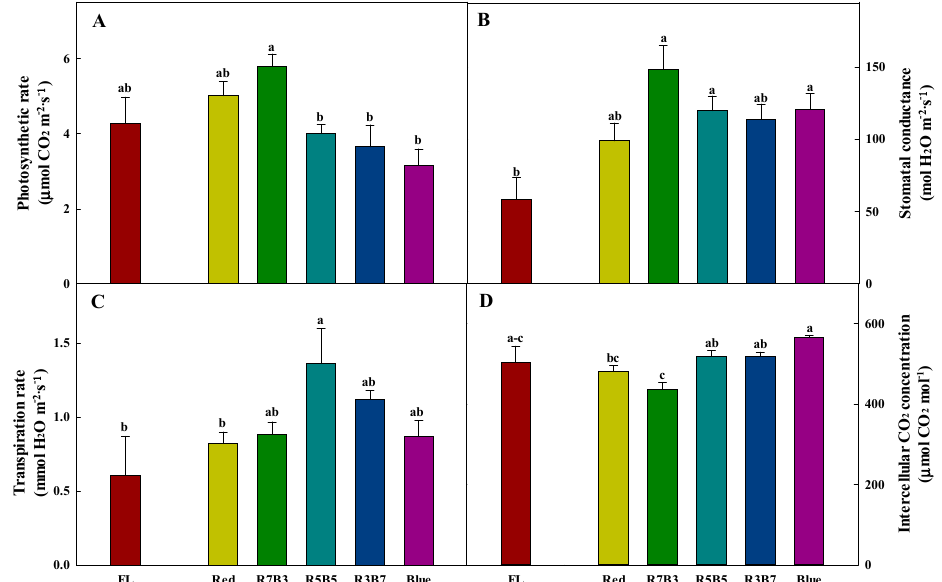
Figure 5. Photosynthetic rate ( A ), stomatal conductance ( B ), transpiration rate ( C ), and intercellular CO 2 concentration ( D ) of Salvia plebeia R. Br. as a ff ected by di ff erent light treatments at 35 days after transplanting. Vertical bars represent the standard deviation of the mean ( n = 3). Di ff erent letters in the same column indicate significant di ff erences based on Tukey’s multiple range test ( α ≤ 0.05).